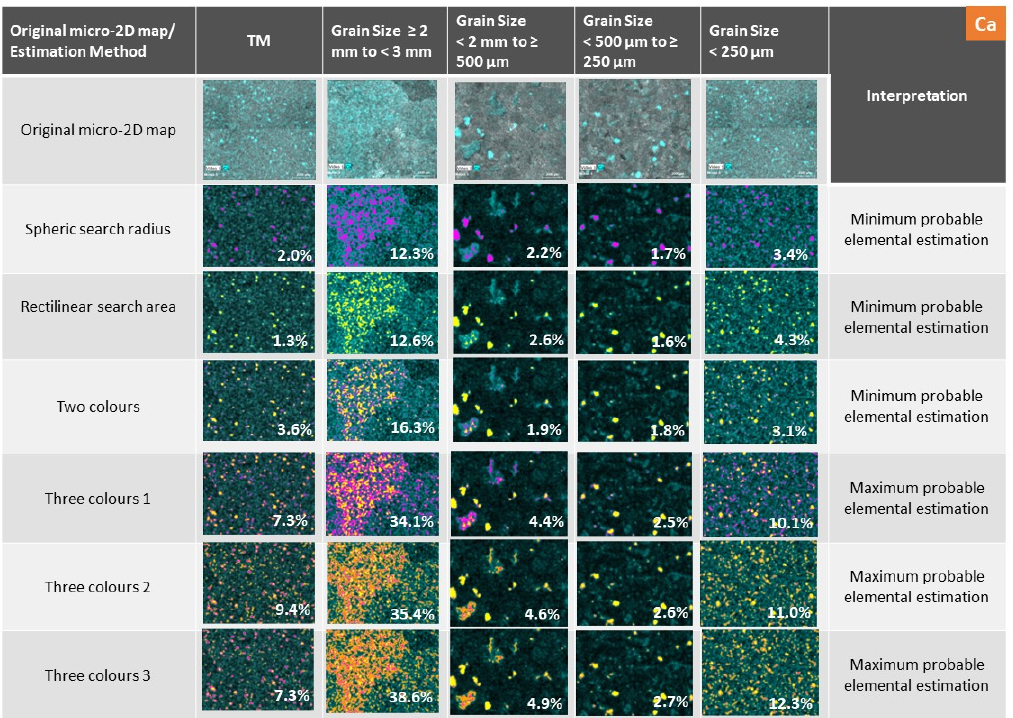
Figure A1. Minimum and maximum probable elemental occurrence in µ-XRF 2D map (percentage of area %) for Ca.